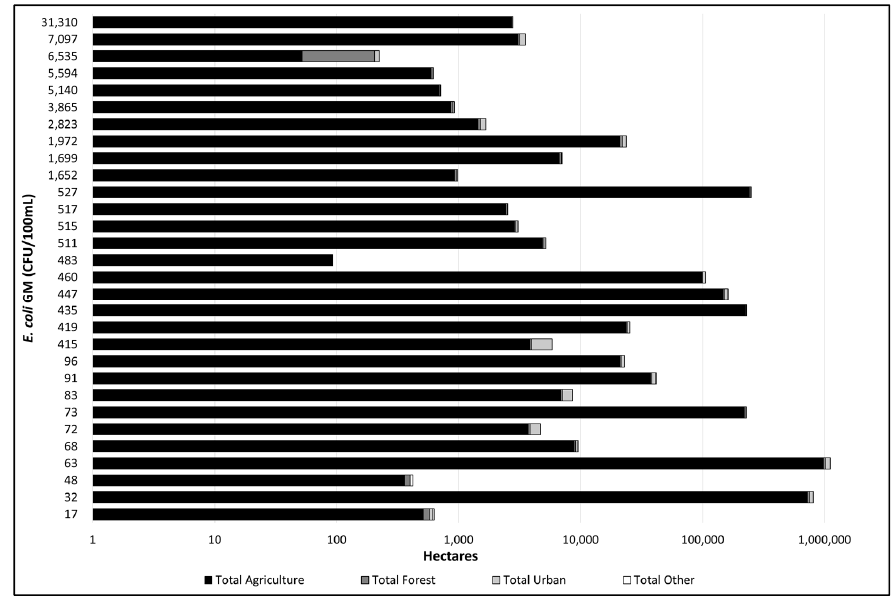
Figure 4. Watershed Area and Land Cover Distribution.